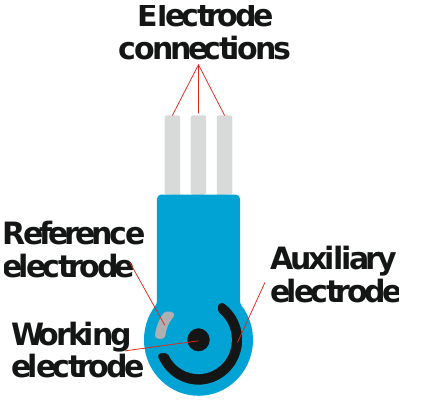
Figure 2. Schematic outline of screen-printed electrodes used with the flow-through cell. The flow-through cell was prepared using Wanhao Duplicator 9/300 (Jinhua Wanhao Spare Parts Co., Jinhua, Zhejiang, China) with a single extruder (nozzle diameter 0.3 mm) from the poly(lactic acid) filaments. The 3D model of the cell designed for the printing is presented in Figure S1. Layer thickness was 0.1 mm and the printing rate was 70 mm · s − 1 . The printing temperature was 220 ◦ C. The flow-through cell consisted of three parts fixed with two screws. The base of the cell had a rectangular notch for fixation of the screen- printed electrode strip. The replaceable enzymatic reactor contained two channels equipped with plastic tubes to pump the solutions through the cell. The schematic outline of the cell is presented in Figure 3. Photographs of a disassembled and assembled flow-through cell with a screen-printed electrode strip is presented in Figure S2.